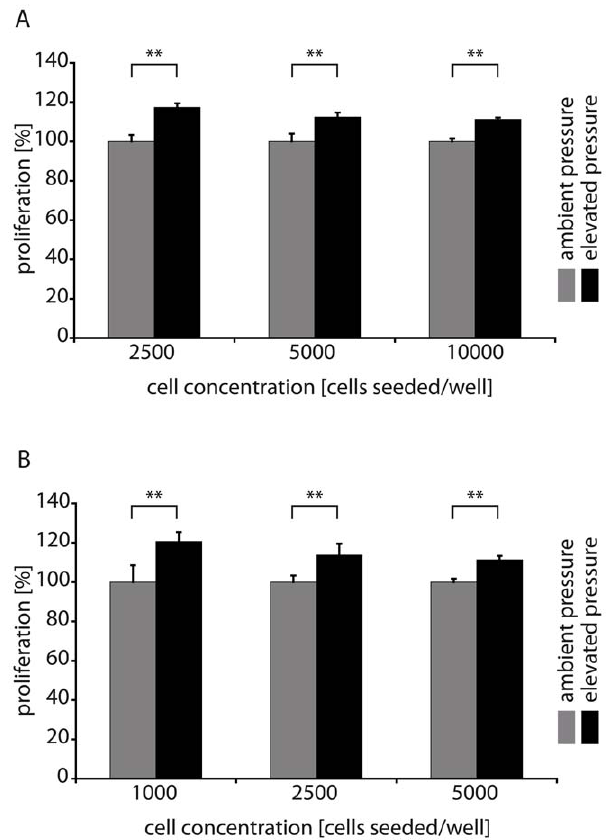
Figure 1. Biomechanical stress induces MEC proliferation. Proliferation of Ben-Men-I cells (A) and primary porcine MECs (B) exposed to elevated and ambient pressure for 2 days. Proliferation of Ben-Men-I cells and PMECs increased in all cell concentration groups that were exposed to elevated pressure compared to control cells cultivated under ambient pressure conditions (shown is a representa- tive result of three independent experiments; error bars represent SD; Student’s t-test: p , 0.01, marked with ** for highly